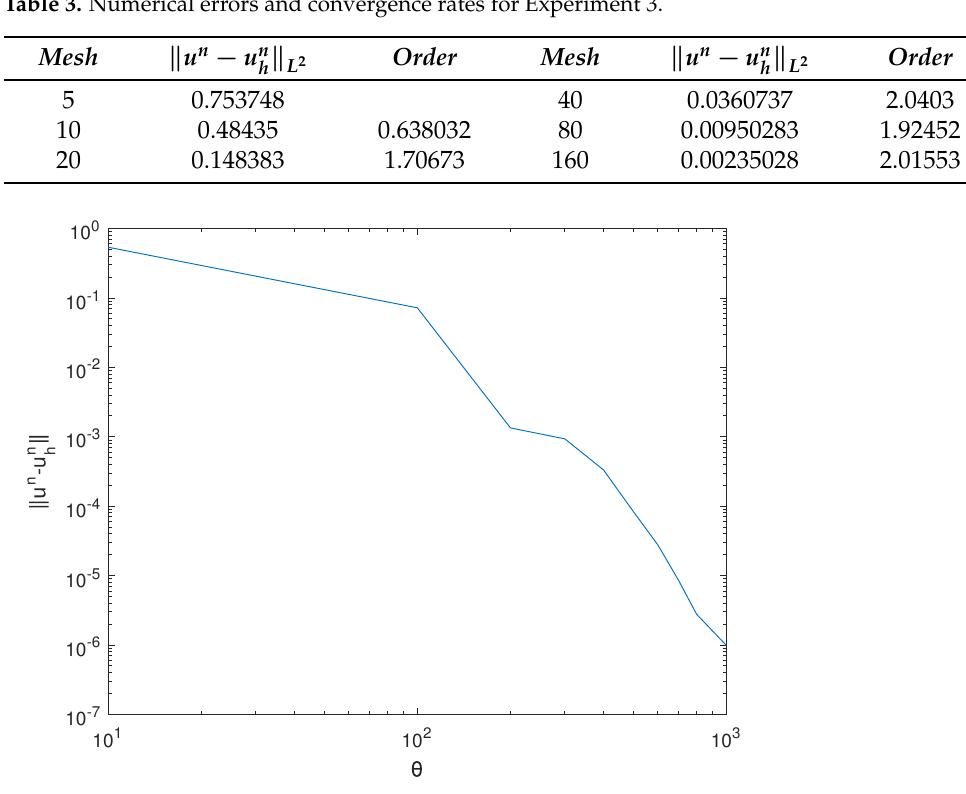
(cid:107) L 2 at mesh 40 and t h